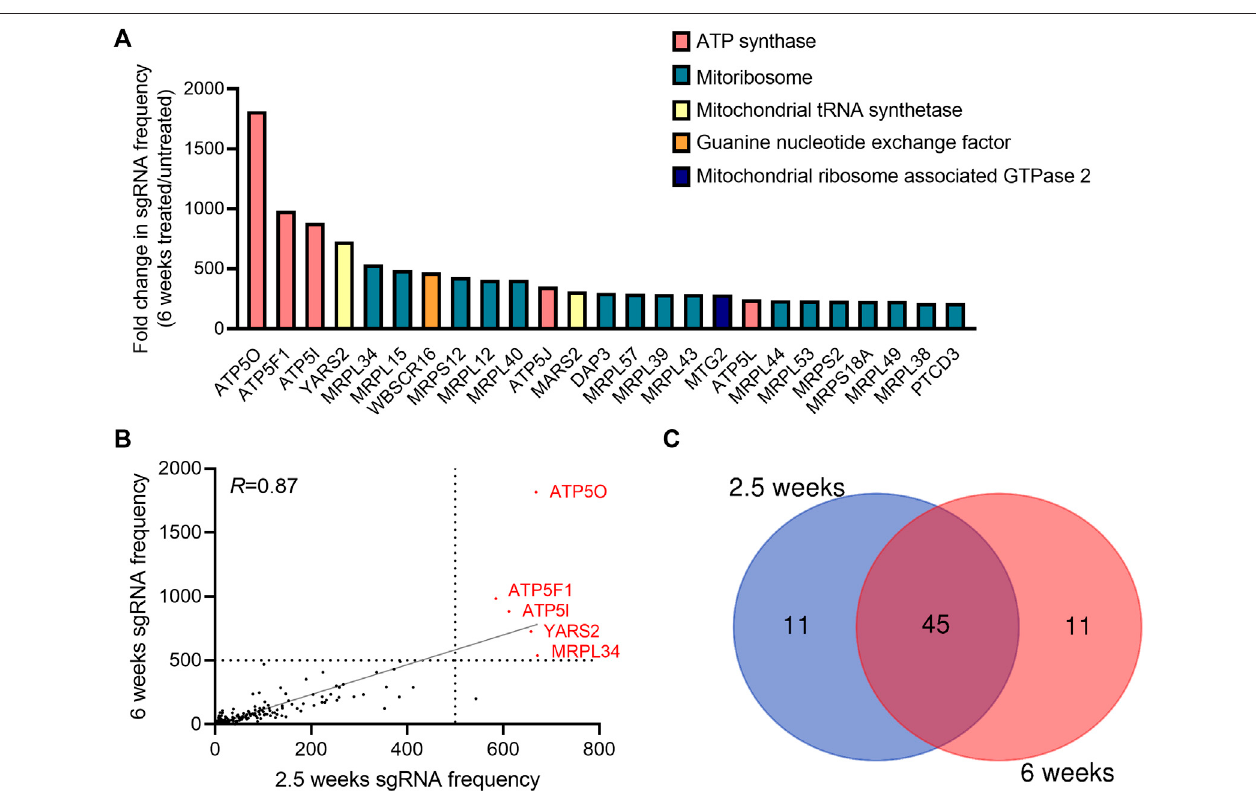
FIGURE 2 | Genes essential to trigger cell death upon long-term induction of dysfunctional mitochondrial. (A) The gene scores for the top 25 genes following treatmentwith100 nMpericidinA,antimycinA,andoligomycinfor6 weeks.ThreesubunitsoftheATPsynthasearethethreebestscoringgenes. (B) Adotplotshowing thepost-screenfrequencyofsgRNAstargetingaparticulargeneintreated(100 nMPAO)cellsfor2.5versus6 weeks.Resultsyieldedthesame5topgenehits: ATP5O , ATP5F1 , ATP5I , YARS2 and MRPL34 . (C) Venn diagram shows the overlaps between thehits among the sgRNAs witha fold change enrichmenthigher than 100.